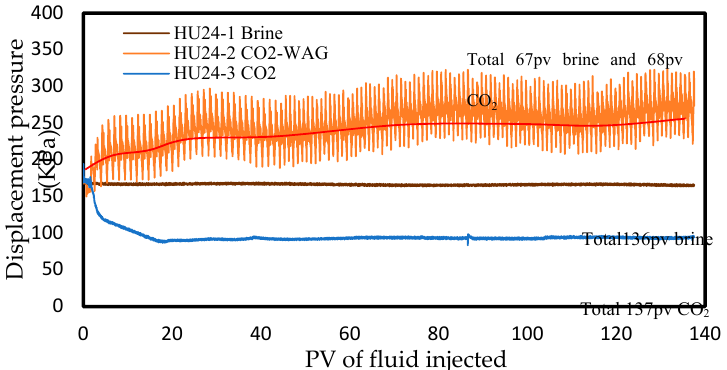
Figure 6. Displacement pressure difference and injection fluid volume of three cores.